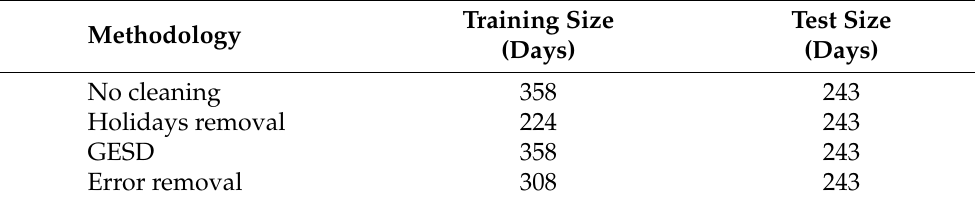
Table 2. Training and test